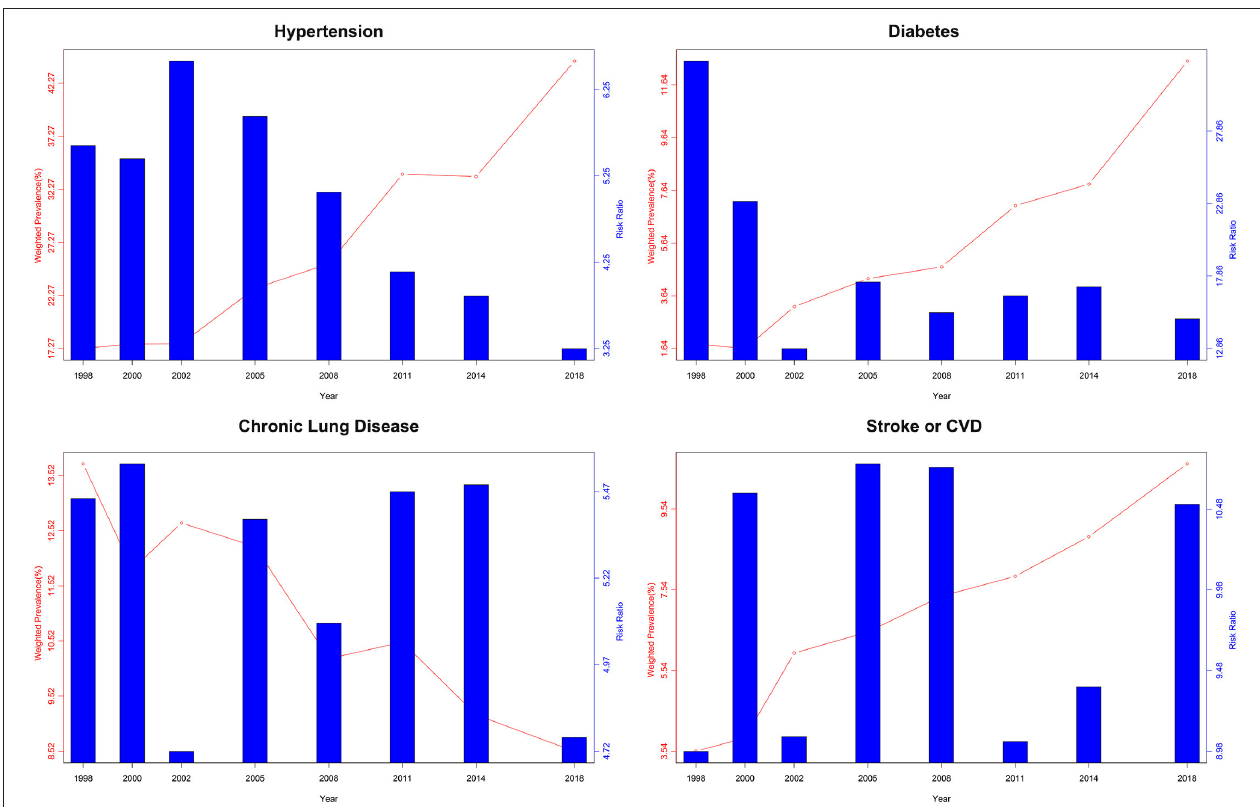
FIGURE 5 | Weighted prevalence and RR of single chronic condition for the survey of eight